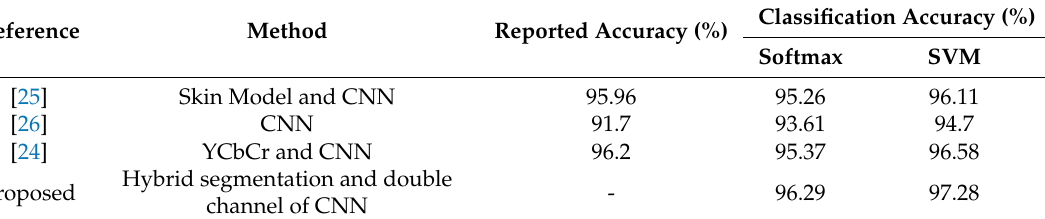
Table 1. Accuracy comparison with state-of-the-art systems (evaluated using our dataset).